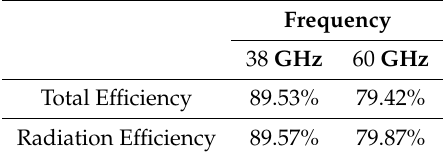
Table 2. Radiation and total efficiencies of the dual-band microstrip patch antenna whose dimensions are shown in Figure 11 (The listed values have been obtained through electromagnetic simulation using CST ® ).